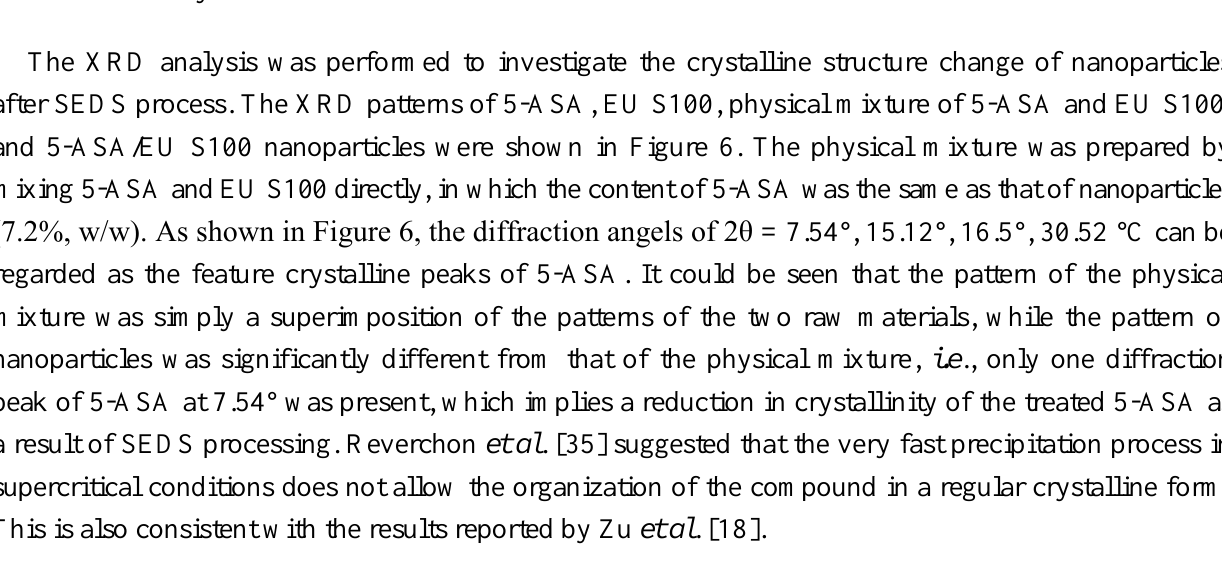
Figure 6. XRD patterns of 5-ASA, EU S100, physical mixture and nanoparticles (12 MPa, 35 °C, 1.0 mg/mL, 1.0